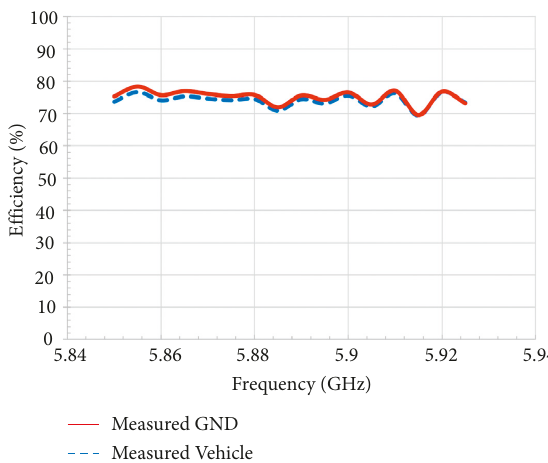
Figure 16: V2X measured efficiency on a ground plane and a vehicle roof.